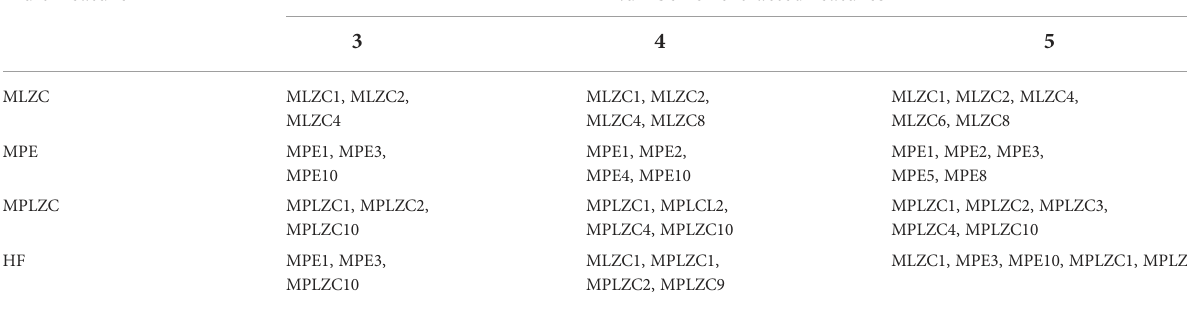
TABLE 4 The feature combinations corresponding to the multi-feature extraction methods.